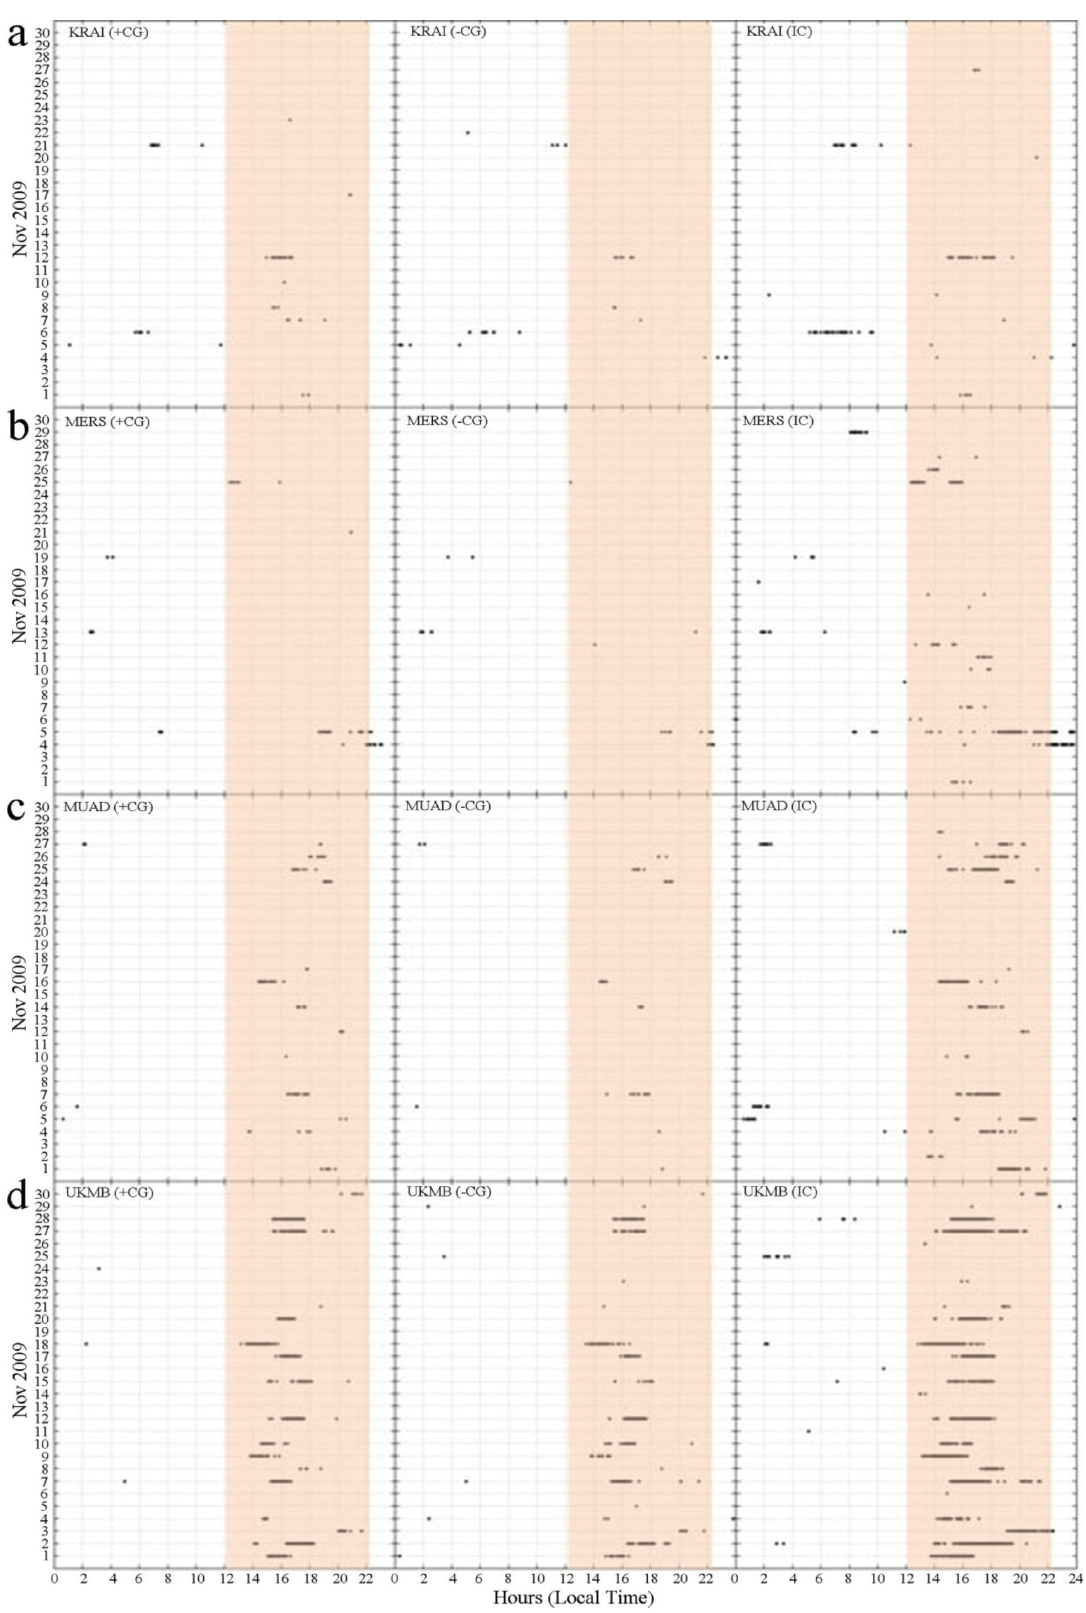
Figure 6. Lightning distribution at four selected stations during the first pre-monsoon (November